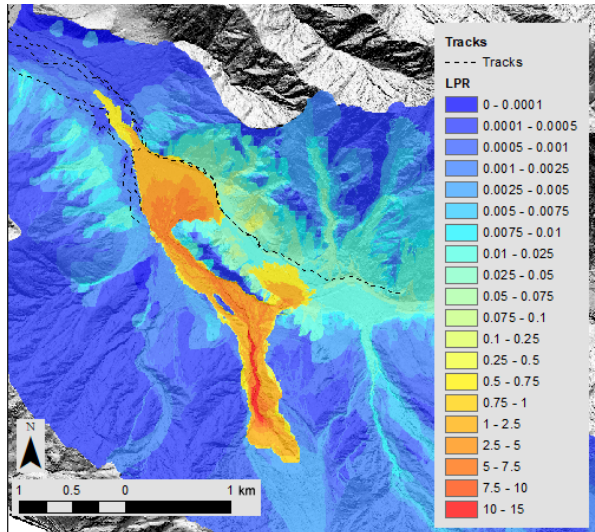
Figure 11. Calculation of local personal risk for the Fox Glacier valley, including recent elevated levels of activity in the Alpine Gardens–Mill’s Creek debris